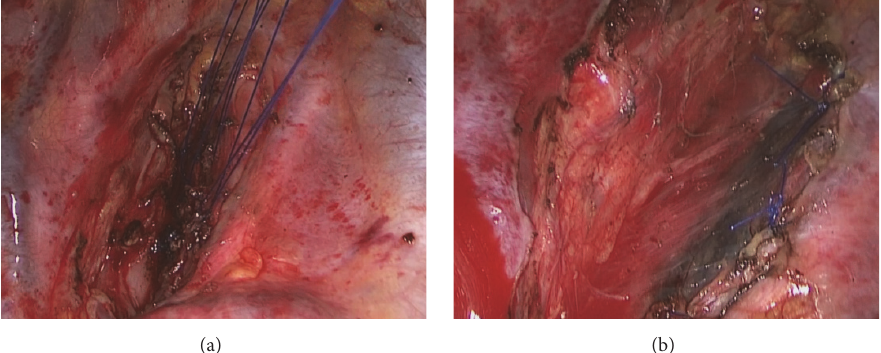
Figure 2: (a) Interrupted stitches using 4-0 Prolene. (b) Reinforcement with a pedicled pleural